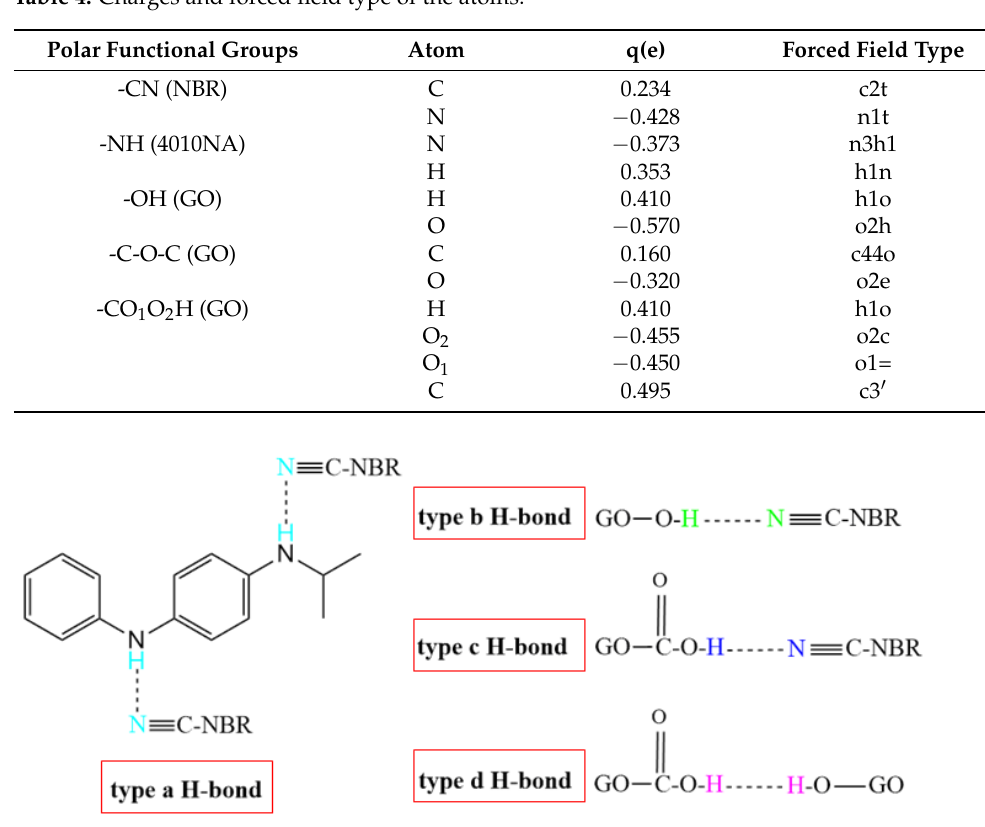
Figure 10. The four types of H-bonds might be formed in the NBR composites.